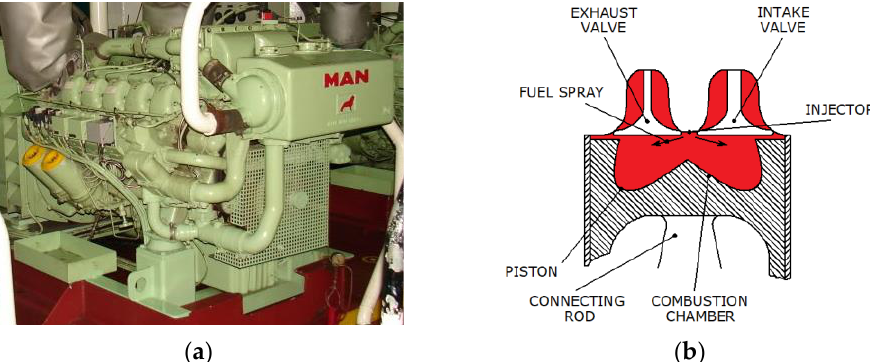
Figure 2. ( a ) Engine analyzed in the present work. ( b ) Section of each cylinder at TDC (top dead center) position.